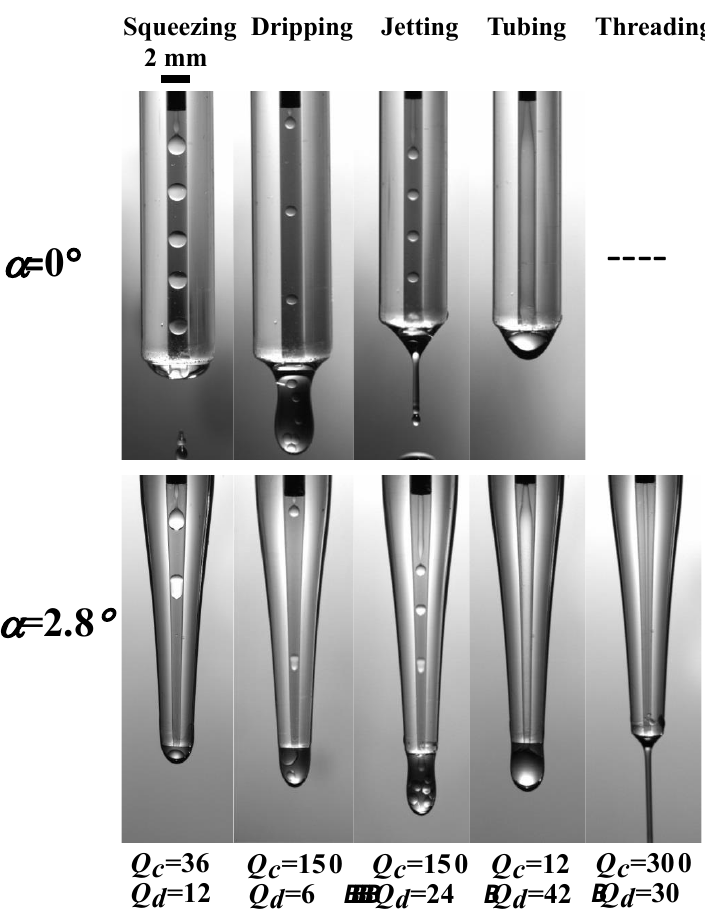
Figure 5. Five flow patterns occurring in coaxial microchannels with convergence angles α = 0 ◦ and α = 2.8 ◦